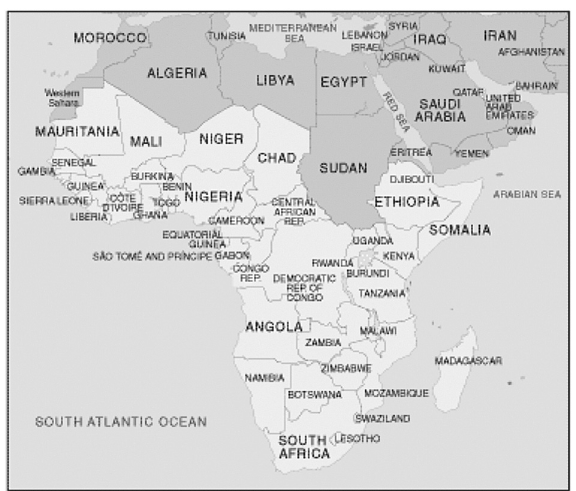
Fig. 1. Africa, with sub-Saharan Africa in lighter gray. Source: Maps.com,